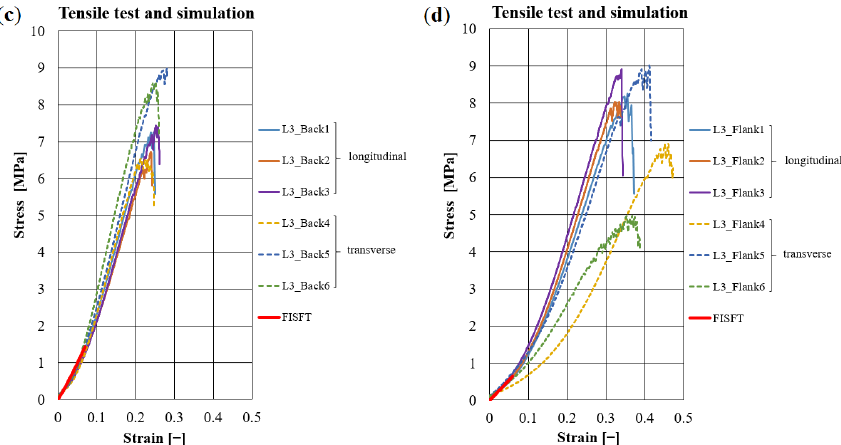
Figure 6. Comparison of experimental results with the stress simulation (FISFT) on meso-structural meshes representing leather samples of Simmental breed, L2: ( a ) back; ( b ) flank; and leather samples of zebu, L3: ( c ) back and ( d ) flank. Continuous red-colored thick lines represent results of numerical simulations; continuous thin lines are experiments for the longitudinal direction, and dotted thin lines for the transverse direction of the samples.